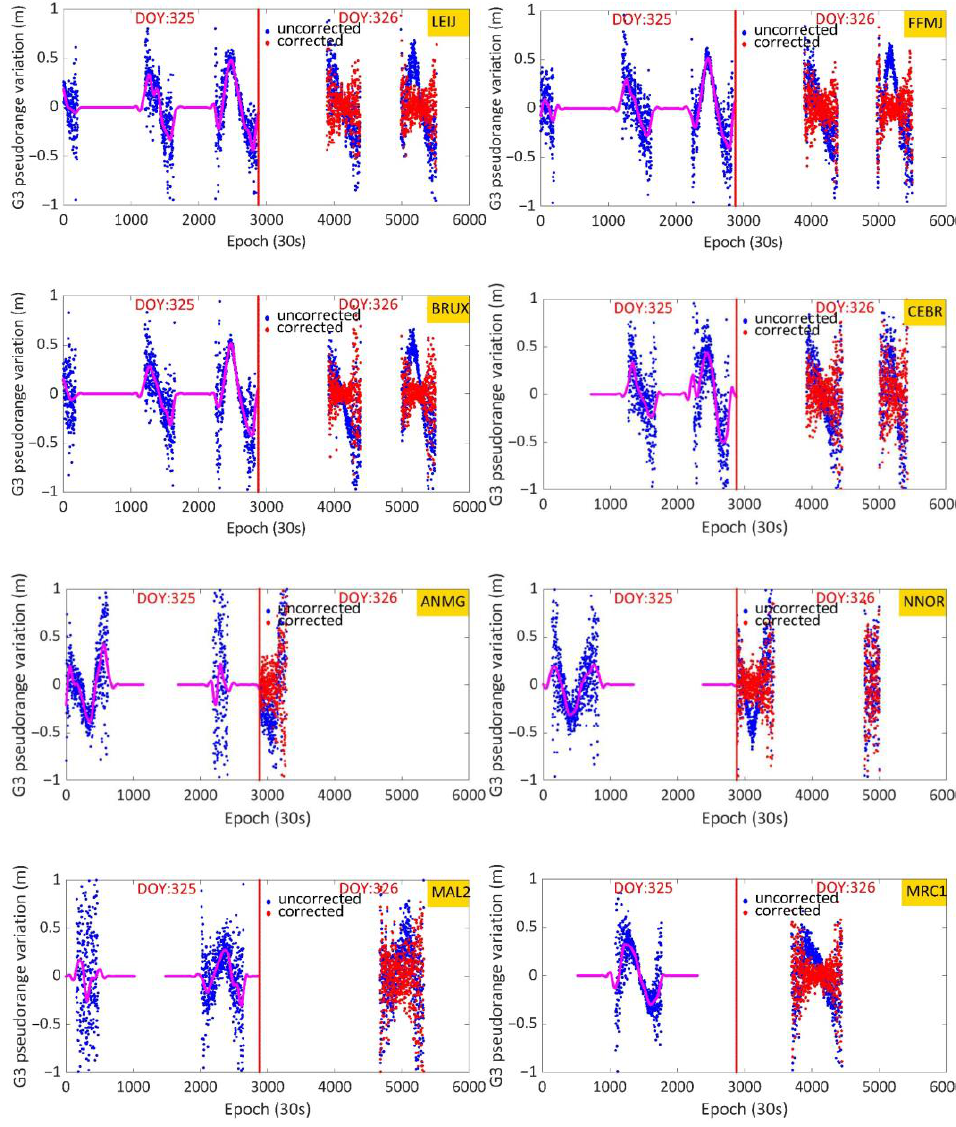
Figure 12. The code pseudorange variations of R21 on DOY 325 and 326, 2020, at LEIJ, FFMJ, BRUX, CEBR, ANMG, NNOR, MAL2, and MRC1 stations. The blue dots denote the original code pseudorange variations, the purple solid line denotes the low-frequency components of the code pseudorange variations using wavelet transformation, the red vertical line denotes the dividing line between DOY 325 and 326, and the red dots denote the corrected CMC